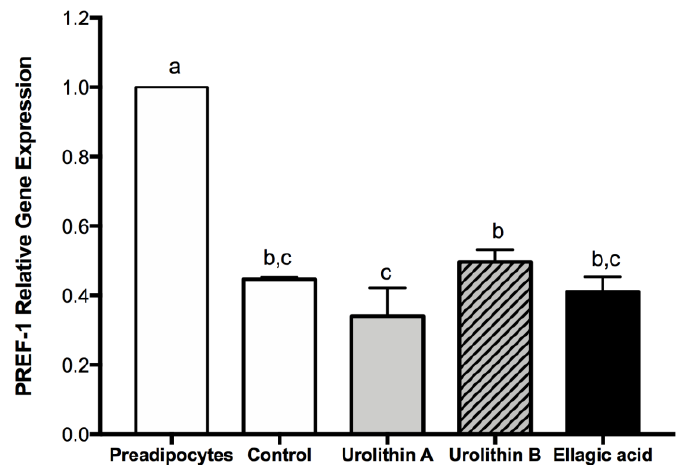
Figure 2. Effect of ellagic acid, urolithin A, and urolithin B over preadipocyte factor 1 (PREF-1) gene expression at day 4 after differentiation induction. 3T3-L1 cells were treated with 25 μM of each compound. For control samples, 0.025% DMSO was used. The values represent the mean ± SD ( n = 3) of three independent experiments. Different letters among bars denote significant changes among treatments and control ( p ≤ 0.05) performed by ANOVA and Tukey’s post hoc test.